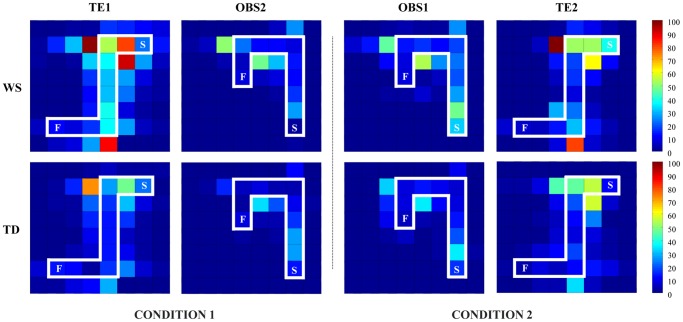
Incorrect items touched on the screen by WS and TD participants in performing the tasks.On the right, the chromatic scale indicates the sum of incorrectly touched items (brown and blue denote maximal and minimal values, respectively). S: starting point; F: final point.